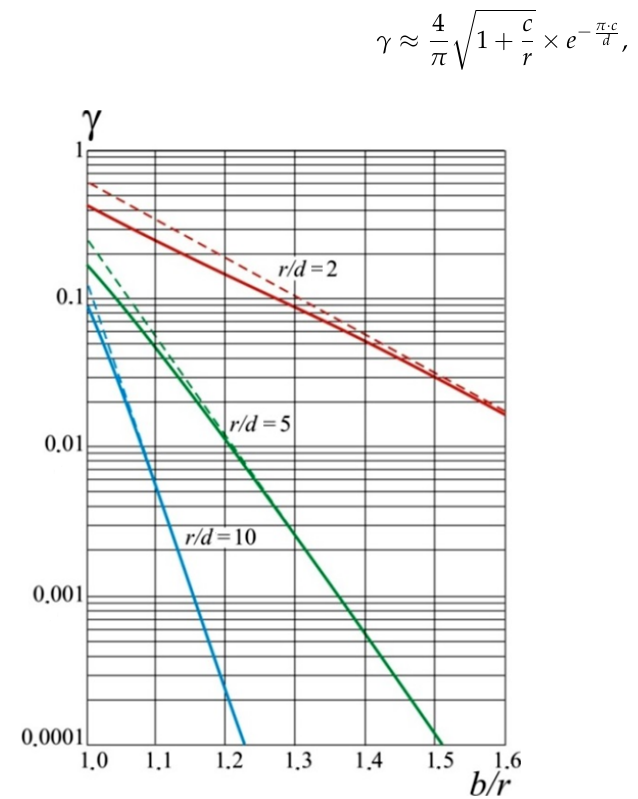
Figure 9. Dependence of error δ = f ( b / d ) from the value of the radius of the guard electrode. Figure 10 shows the curve family γ = f ( c ) for different values of the active electrode radius r and the maximum gap to shaft surface d max = 5 mm.